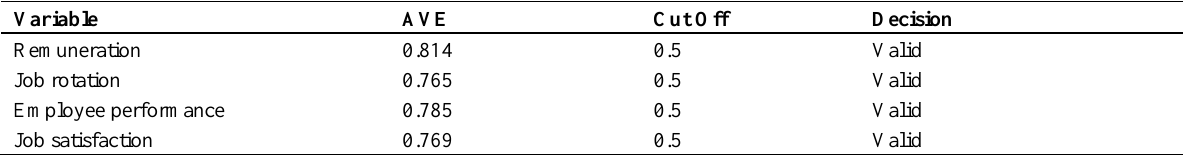
Table 4: Results of Average Variance Extracted (AVE)